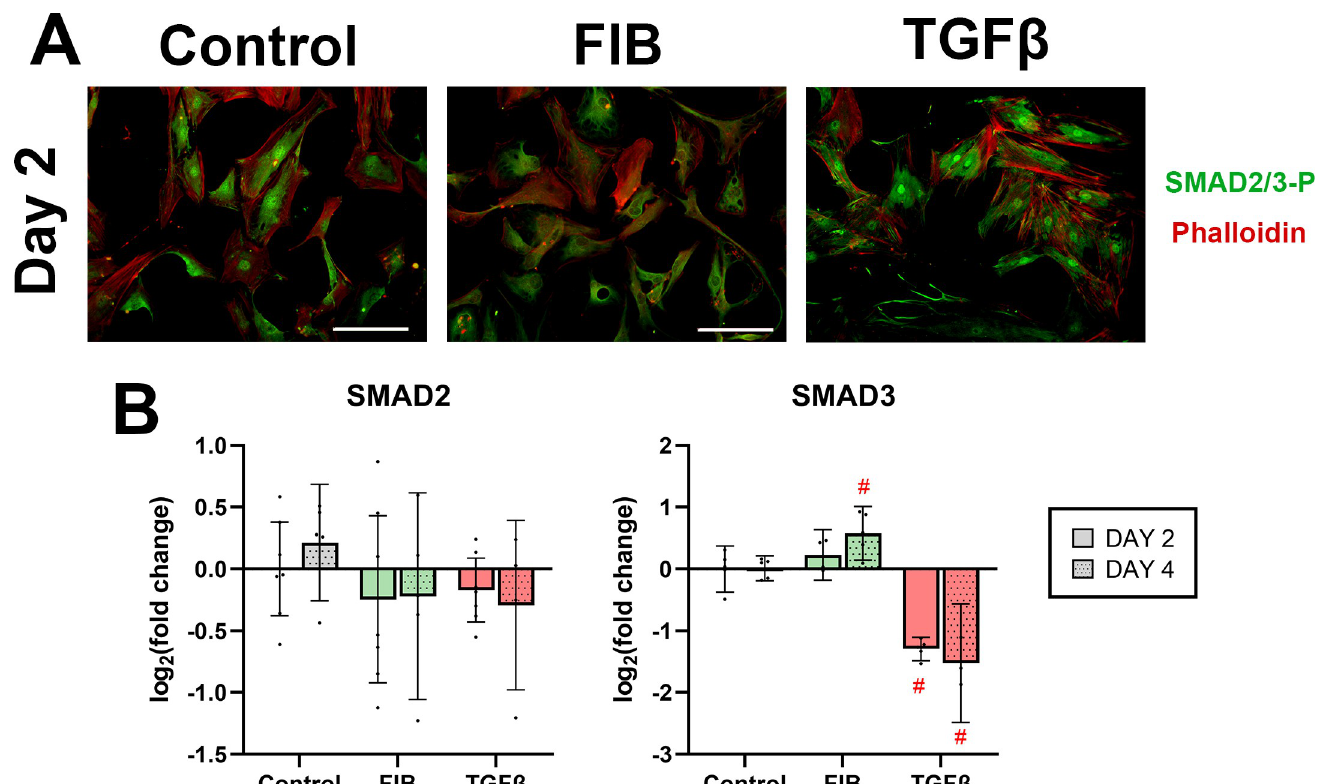
Fig 5. FGF-2 reduces SMAD immunostaining, no effect on expression of SMAD genes. (A) shows hVICs on day 2 stained for activated SMAD2/3 complex (green), counterstained with phalloidin (red), scale bars represent 100 μ m. Representative images of day 4 did not appreciably differ from day 2, and are available in the supplementary materials (S3). (B) shows RT-qPCR results of expression of SMAD2 and SMAD3 respectively at day 2 and 4. � p < 0.05, #p < 0.01, dots represent biological replicates (n = 7 on day 2, n = 5 on day 4), error bars represent 95% CI.